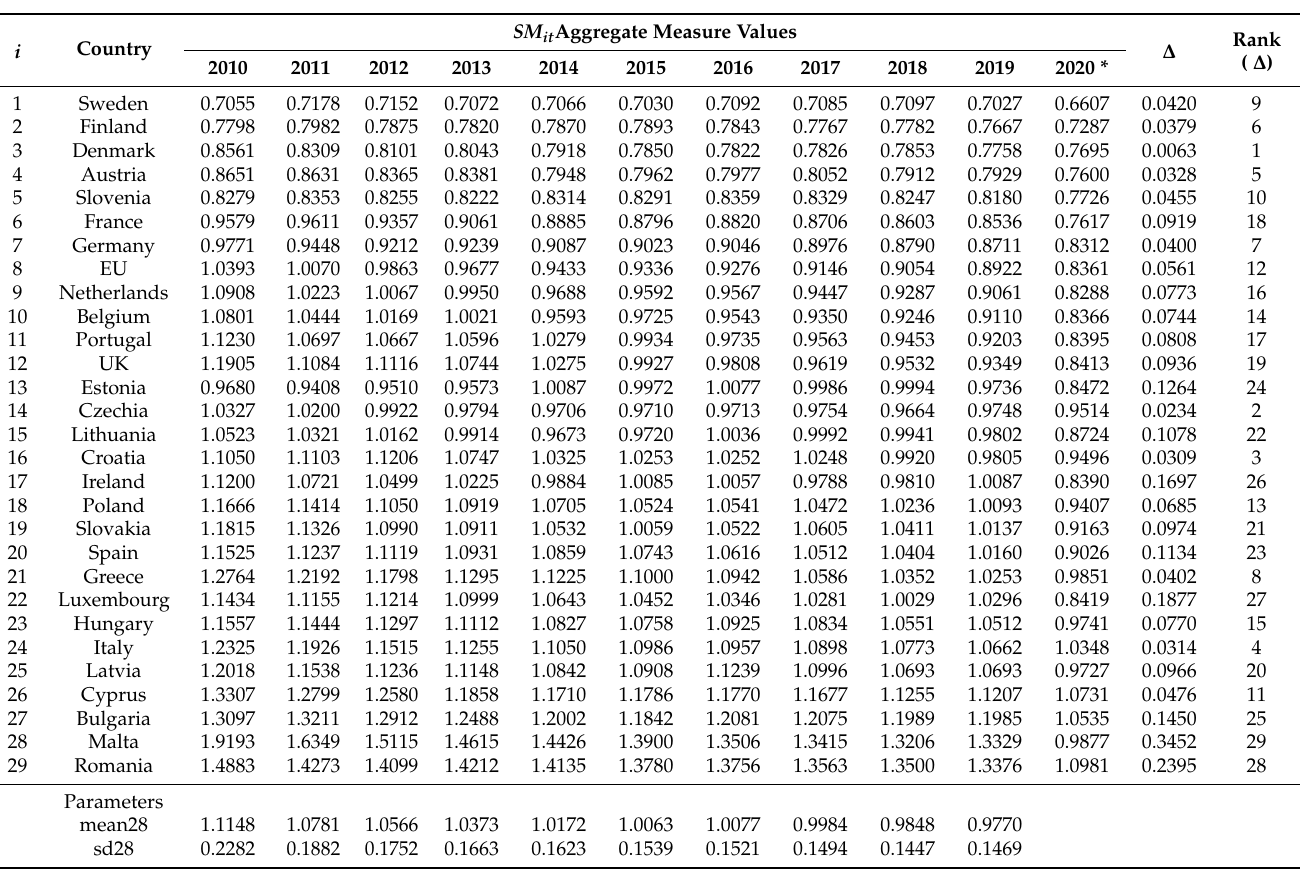
Table 5. SM it aggregate measure values for the national-level target analysis, showing changes in the implementation of the EU 2020 Strategy from 2010 to 2019, and sorted by 2019